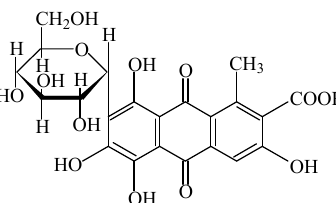
Figure 3. Structural formula of carminic acid (E120).